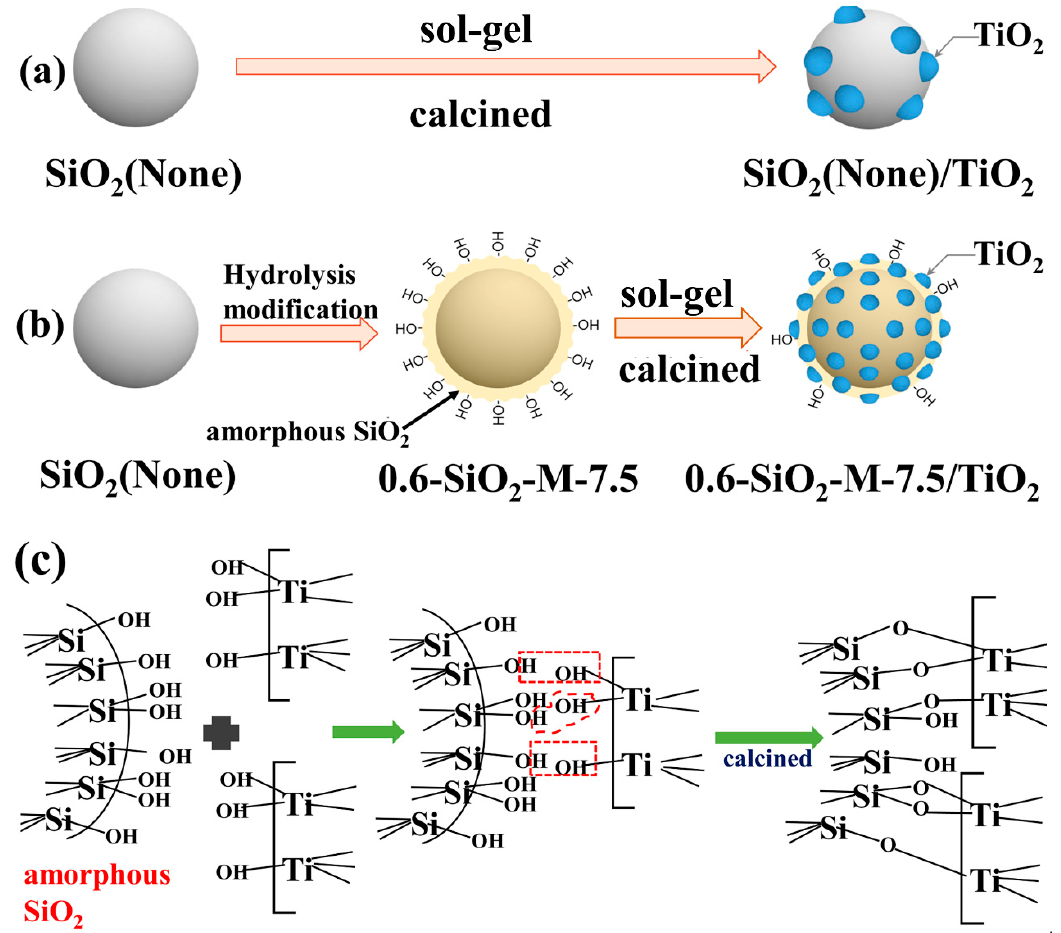
Figure 11. Schematic diagram of loading nano-TiO 2 on SiO 2 microspheres ( a – c ).